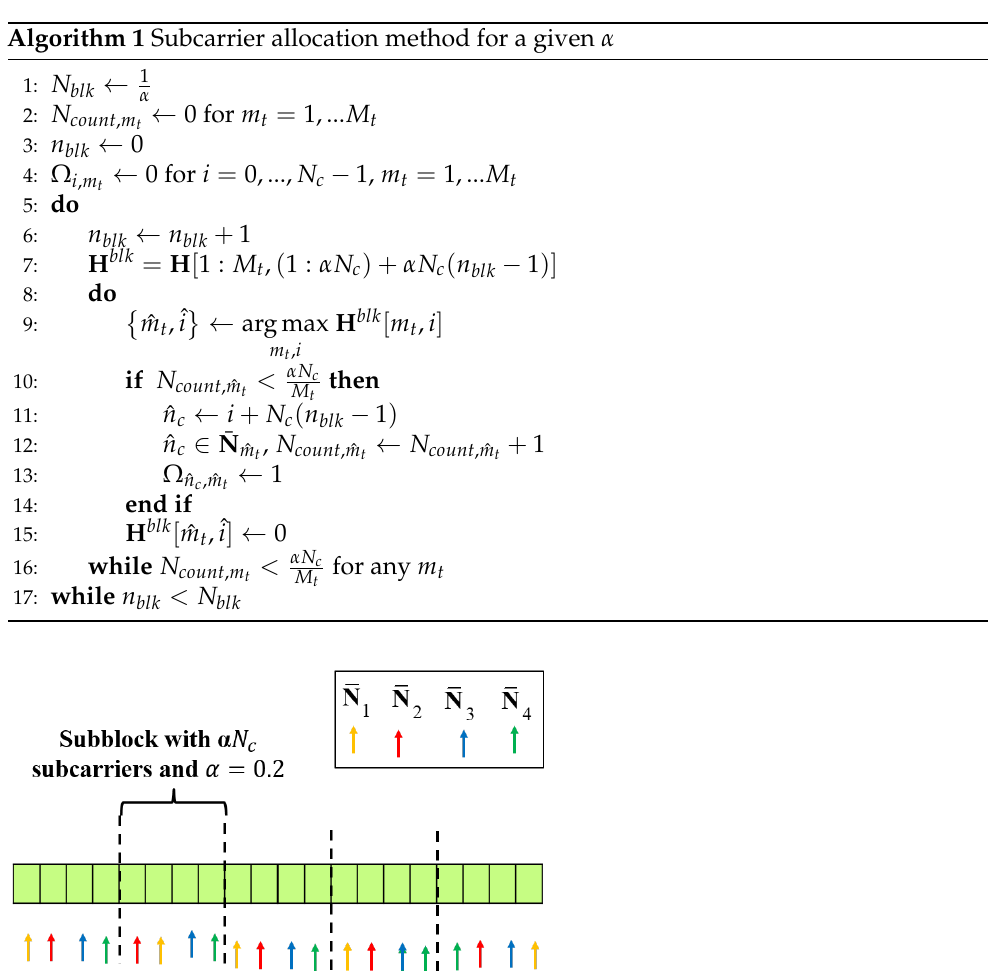
Figure 4. An example of the operation of the proposed subcarrier allocation strategy with N c = 20, α = 0.2, and M t =